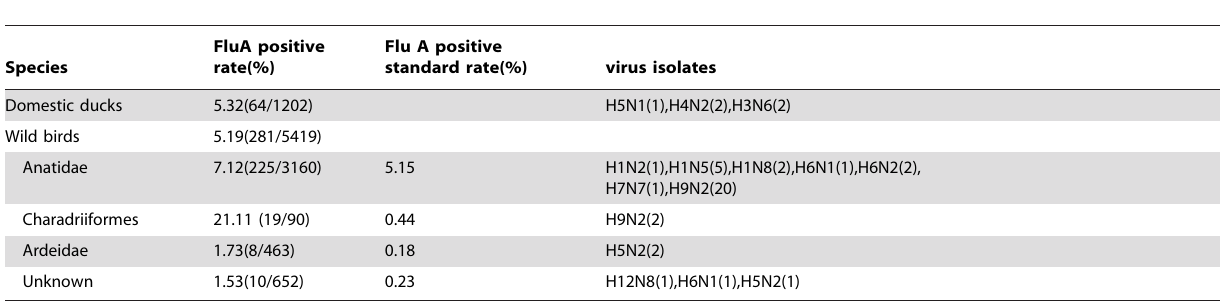
Table 3. Detection of AIVs in samples collected from wild birds and domestic ducks.